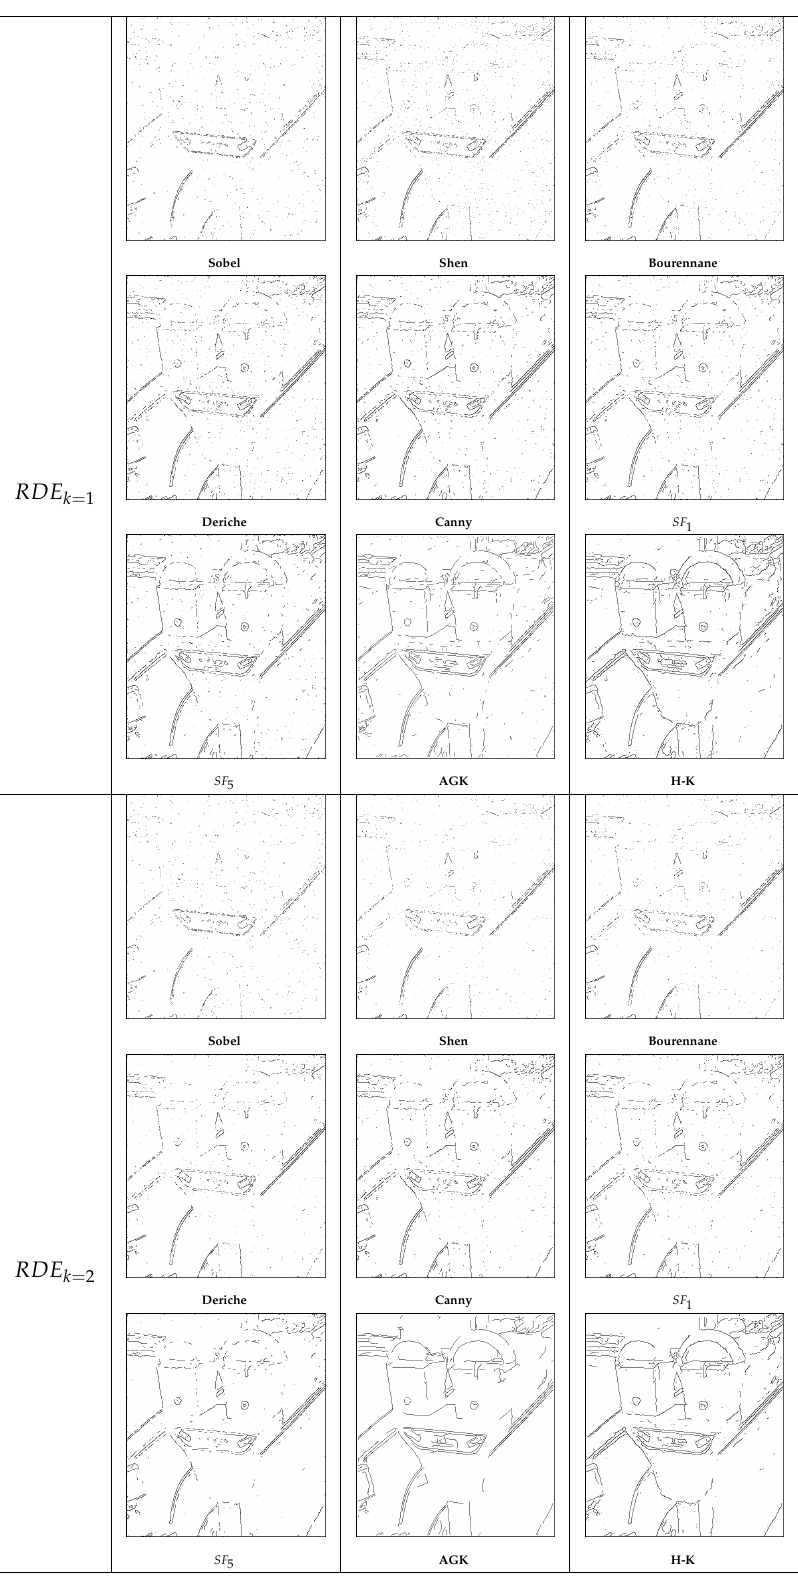
Figure 41. Ideal segmentations for several edge detectors on image parkingmeter, PSNR = 14